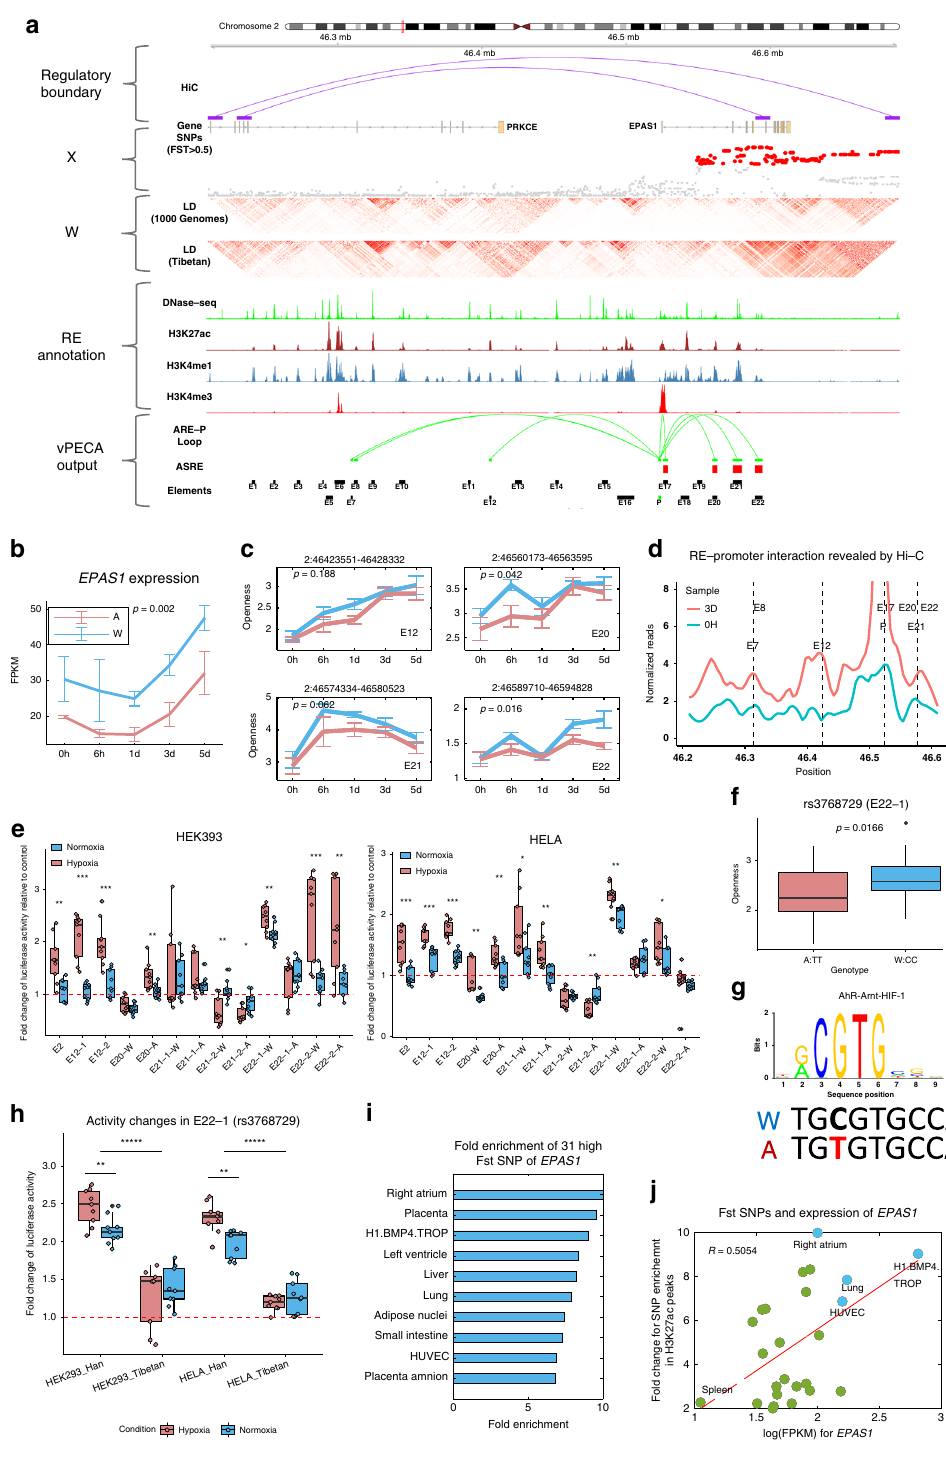
(Fig. 3g). It changes the fi rst position of mandatory core consensus CGTG in the high-quality motif derived from oxygen-regulated elements of 70 known HIF target genes 22 – 24 , which partly explain the strong effect in the reporter